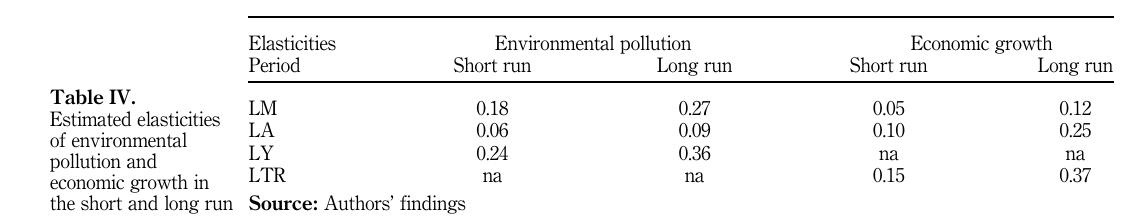
Table III. Results of the GDP model estimation